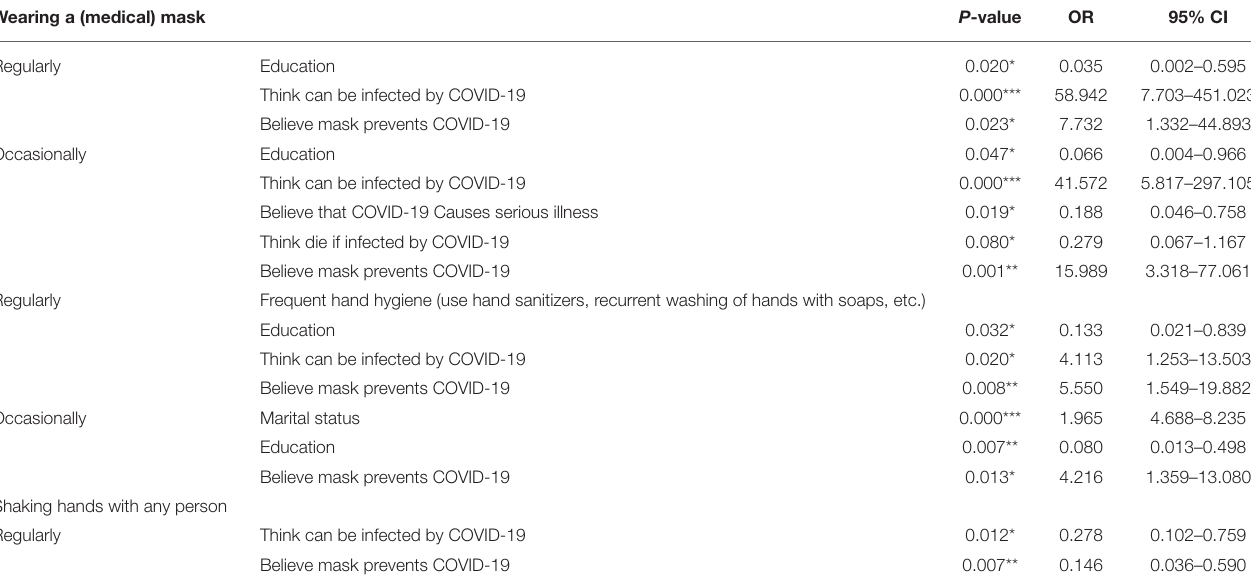
TABLE 7 | Multinomial logistic regression